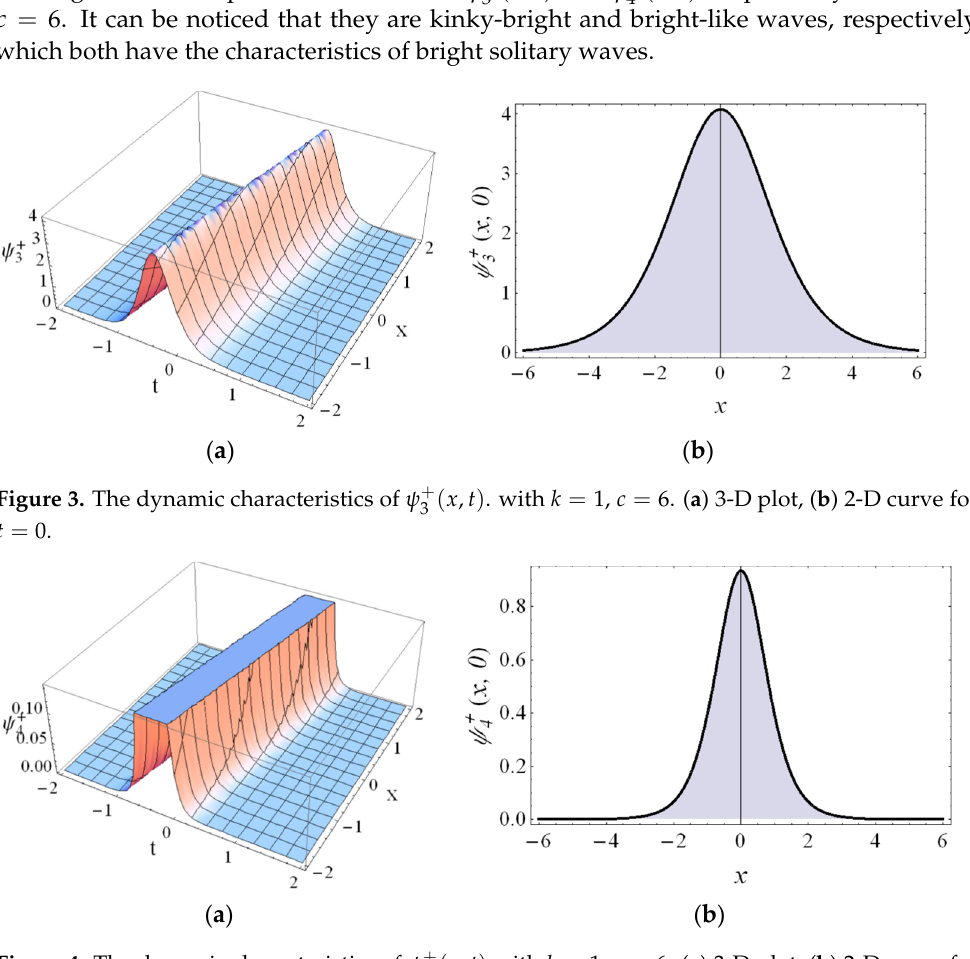
Figure 4. The dynamic characteristics of ψ + t =